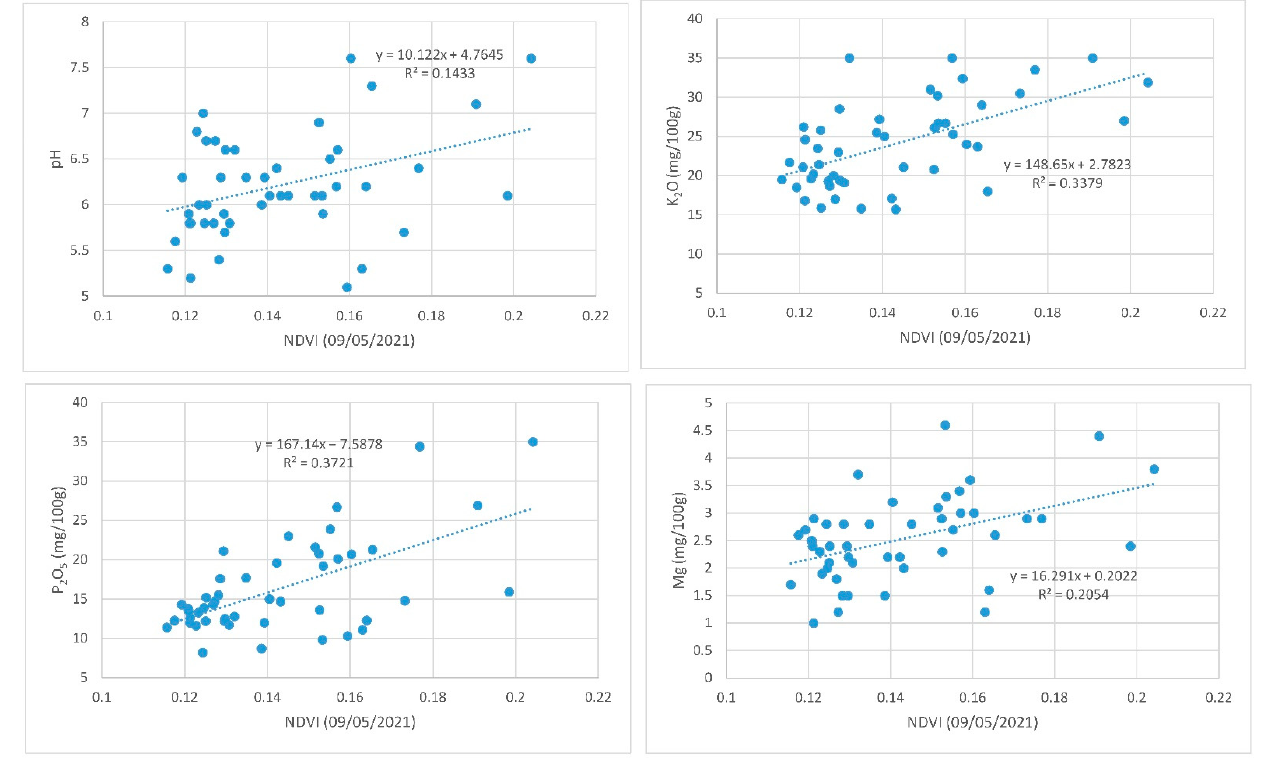
Figure 4. The relationships between NDVI and pH, as well as nutrient content in soil evaluated using simple linear regression.